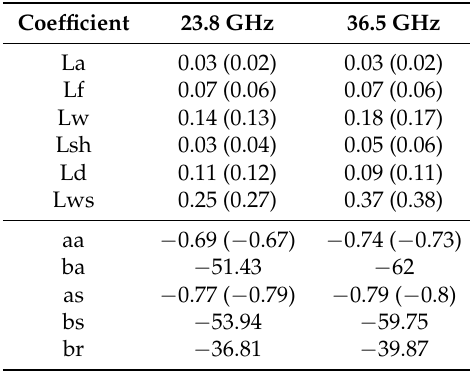
Table A1. Characterisation Coefficients from on-ground calibration. Values in parentheses are the updated values after in-flight